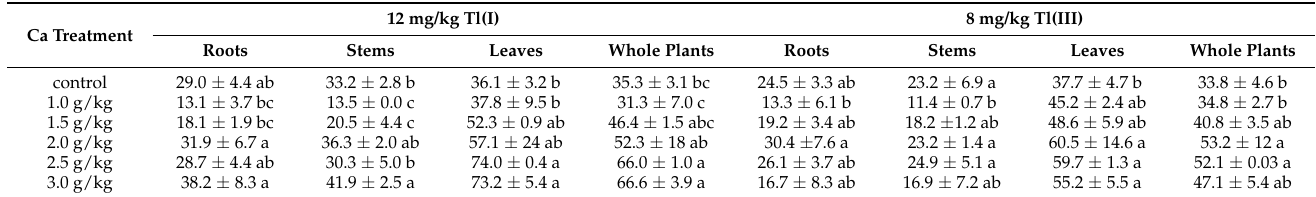
Significant differences among different Ca treatments are indicated by lowercase ( p <